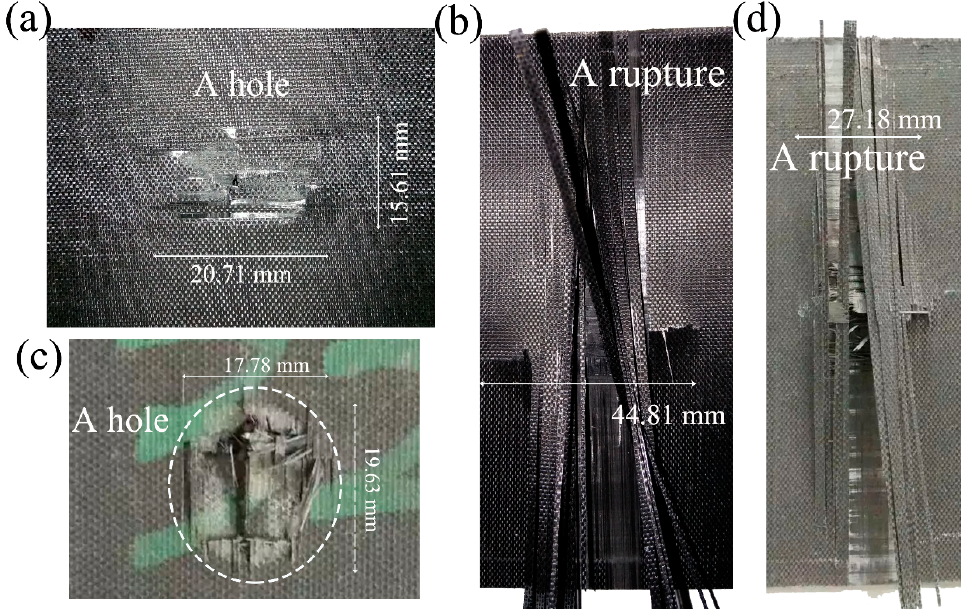
Figure 8. Photos of ( a ) the front and ( b ) back faces of a dry specimen, ( c ) the front and ( d ) back faces of a saturated specimen under an impact velocity of 86 m/s with the cone-ended projectile.